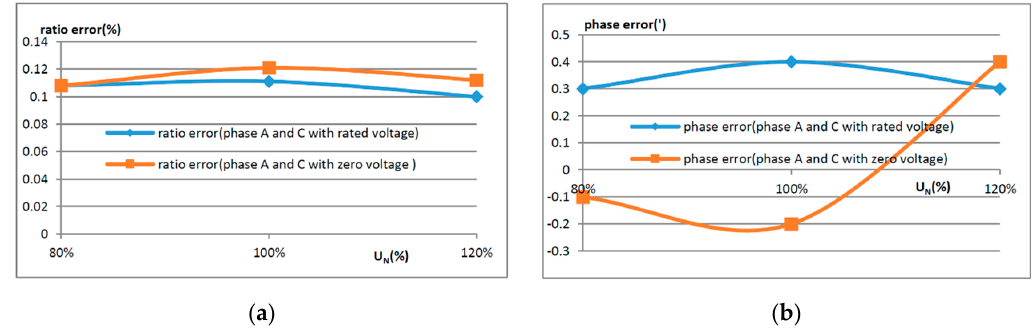
Figure 11. Influence of adjacent phases on OVT. ( a ) Influence of adjacent phases on OVT’s ratio error; ( b ) Influence of adjacent phases on OVT’s phase error.